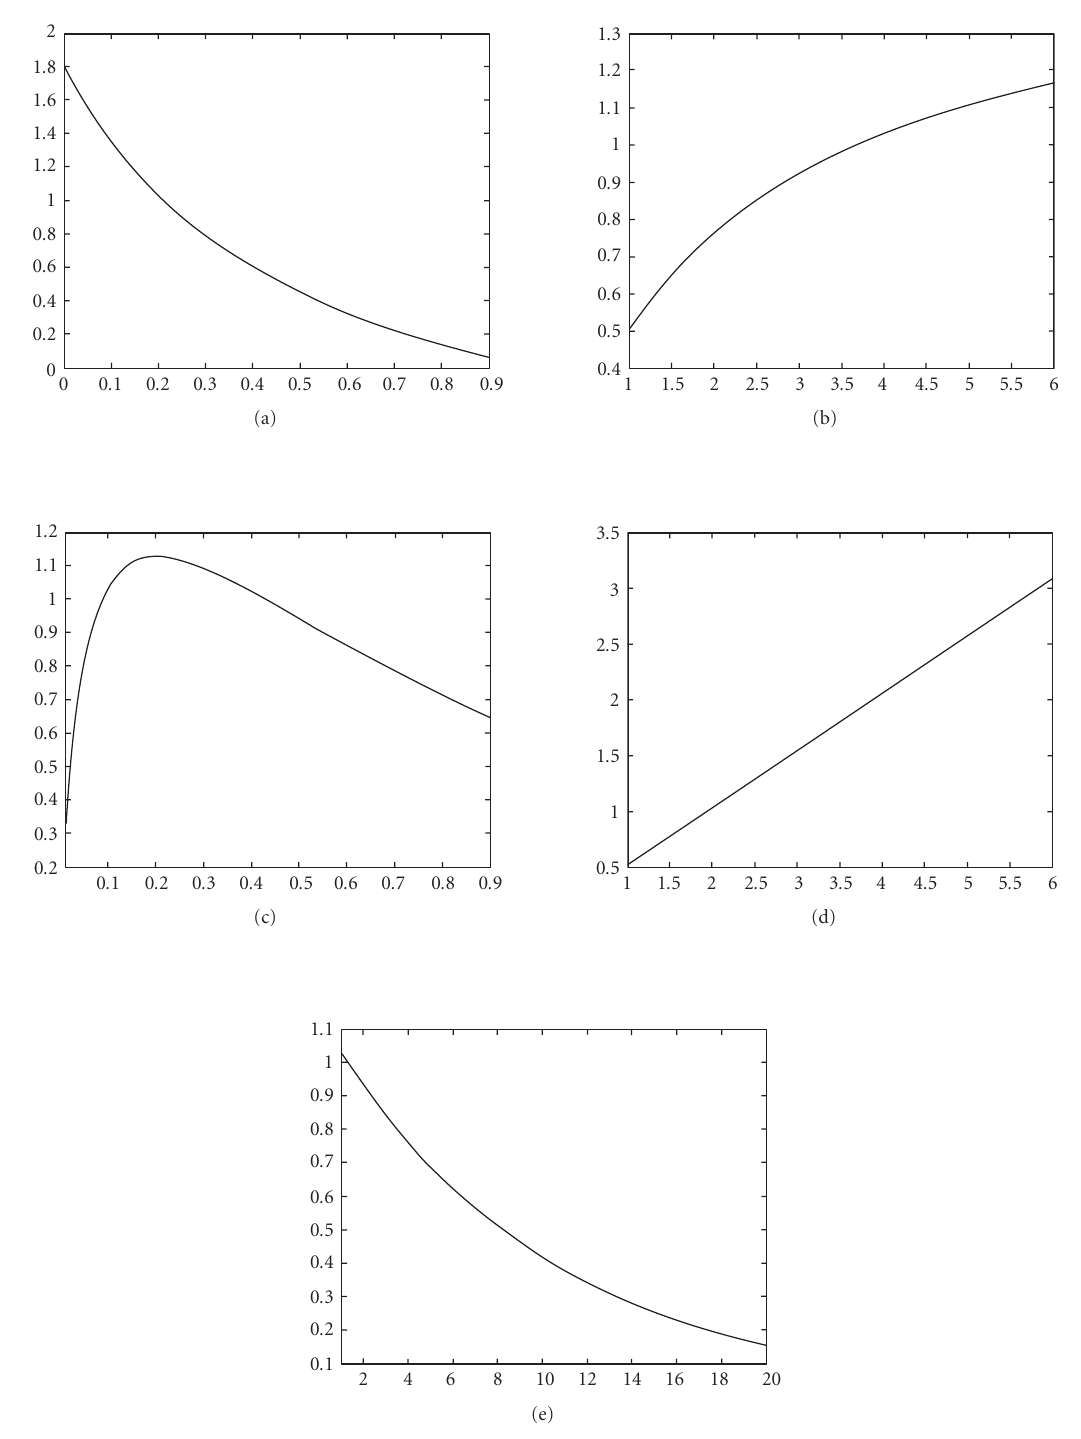
Figure 2: The relationship between the parameters and R ∗ : (a) “ θ − R ∗ ,” (b) “ τ − R ∗ ,” (c) “ μ − R ∗ ,” (d) “ R 0 − R ∗ ,” (e) “ h − R ∗ .”